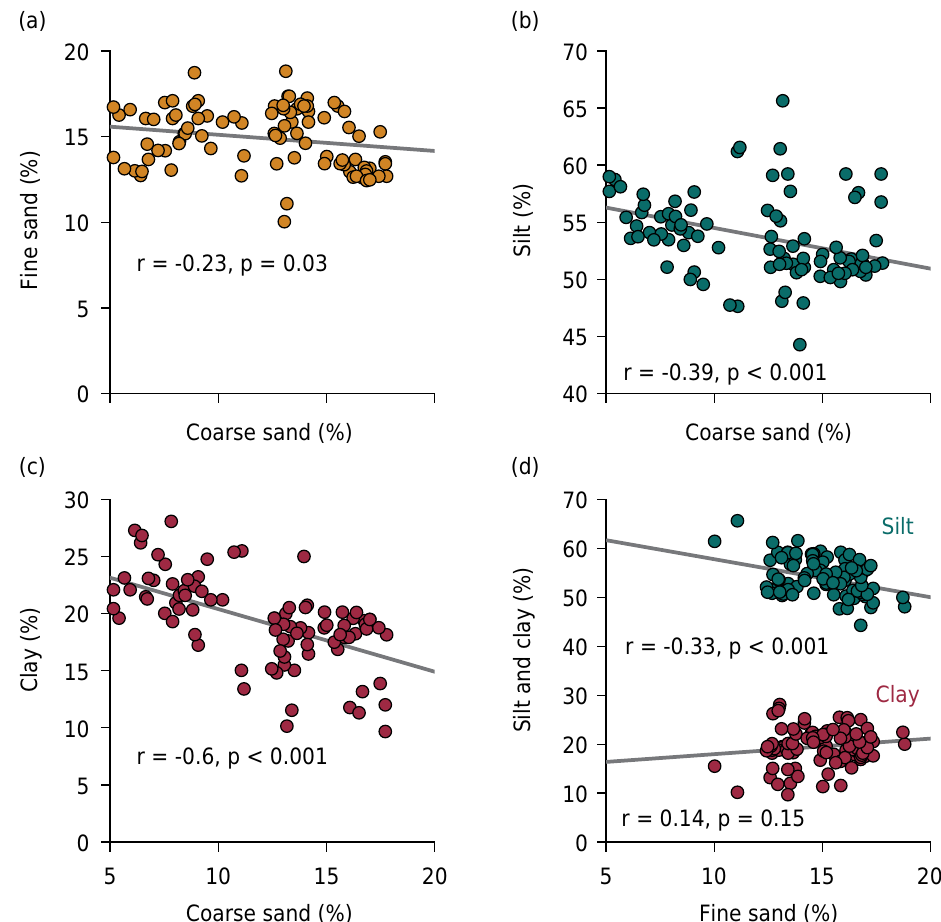
Figure 5. Correlation between particle-size fractions determined with all the treatments.